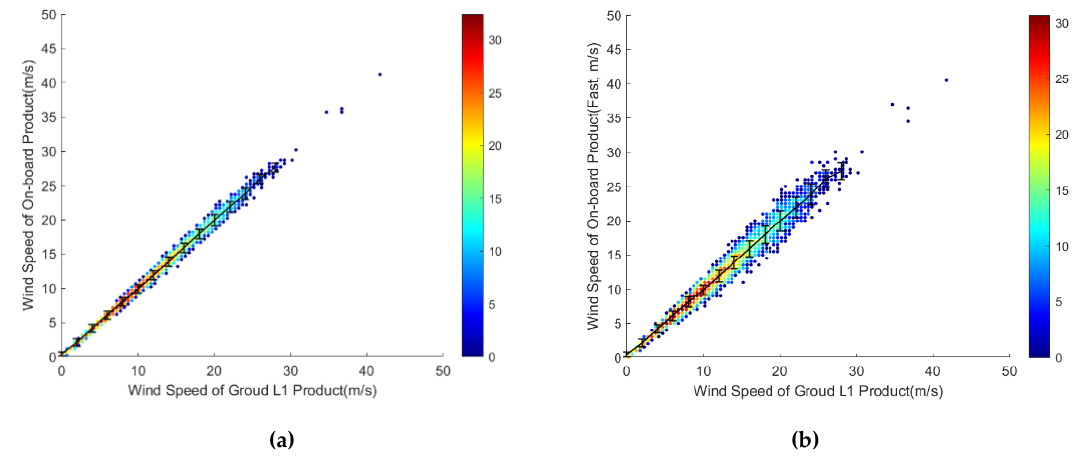
Figure 10. Correlation and error bars between the ground L2 product wind speed and the on-board wind speeds derived from a full GMF LUT ( a ) and a desampled GMF LUT ( b ). Color indicates wind speed in m/s.